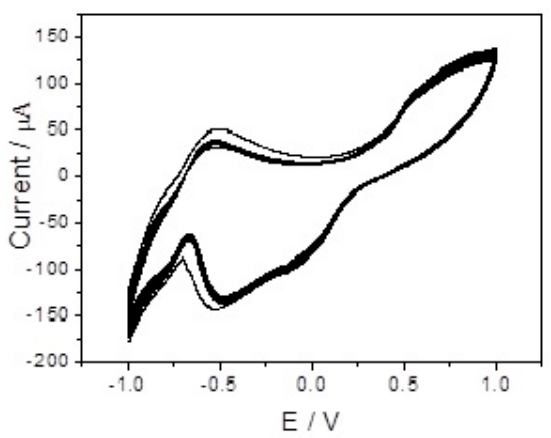
Figure 9. The repeatability of branch-trunk Ag hierarchical nanostructures/GCE in 1 mM H 2 O 2 solution after 10 scanning cycles.